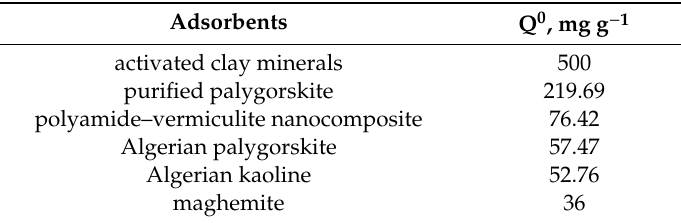
Table 3. Several methylene blue adsorption capacities onto various kinds of natural and modified minerals